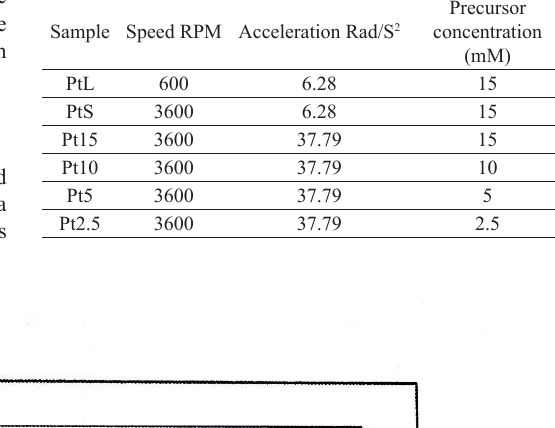
Table 1. Fabricated thin films